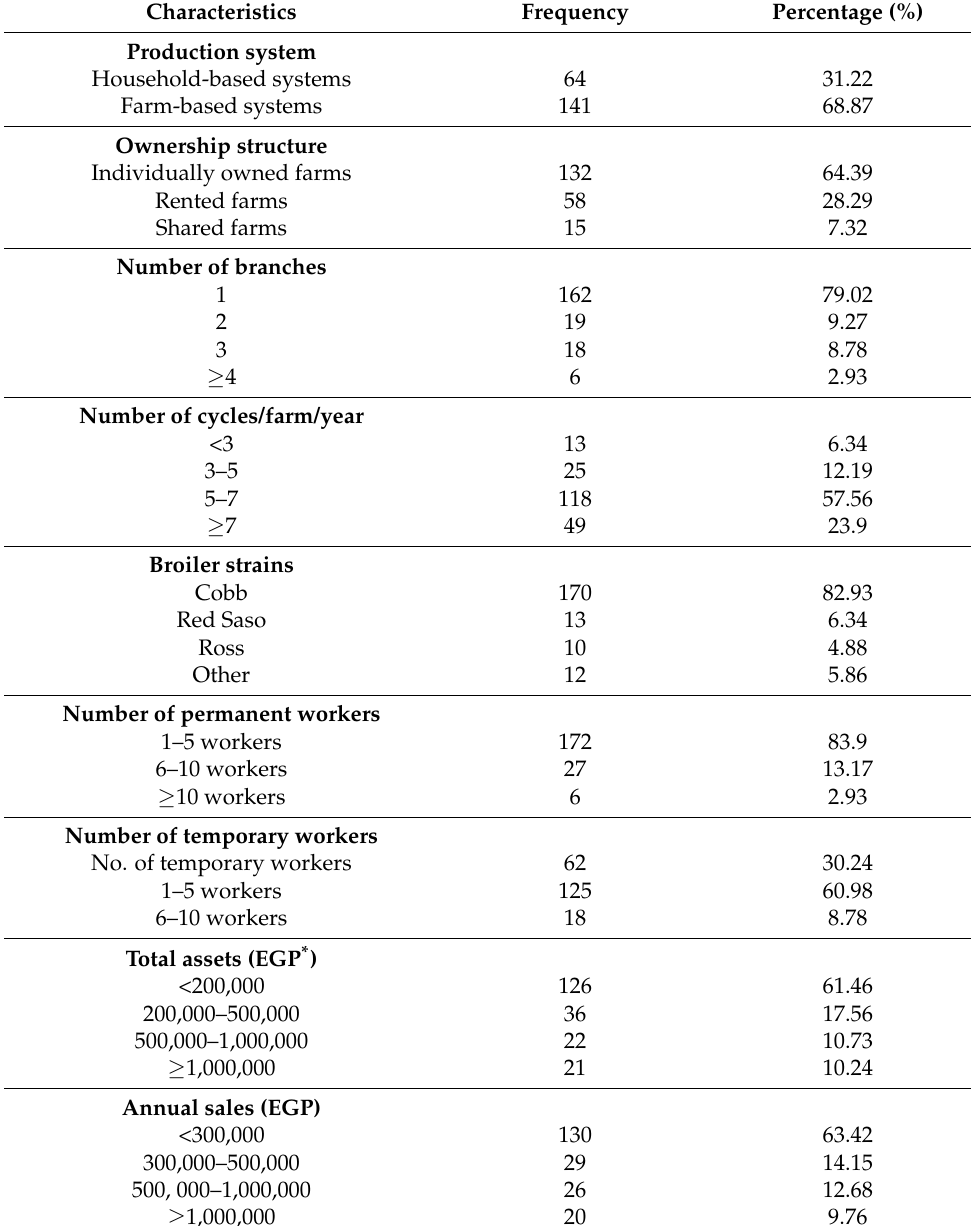
Table 3. Characteristics of the surveyed small-scale commercial broiler farms ( n =